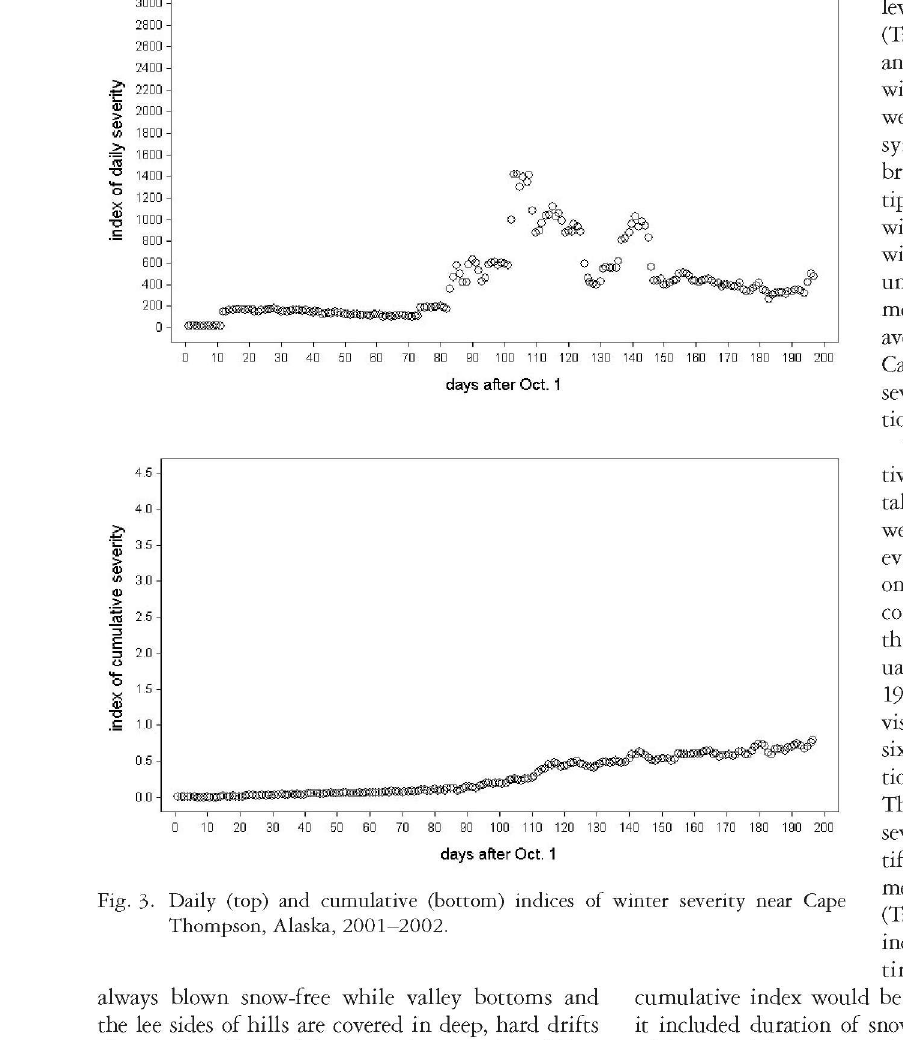
always blown snow-free while valley bottoms and the lee sides of hills are covered in deep, hard drifts almost regardless of how much snow has